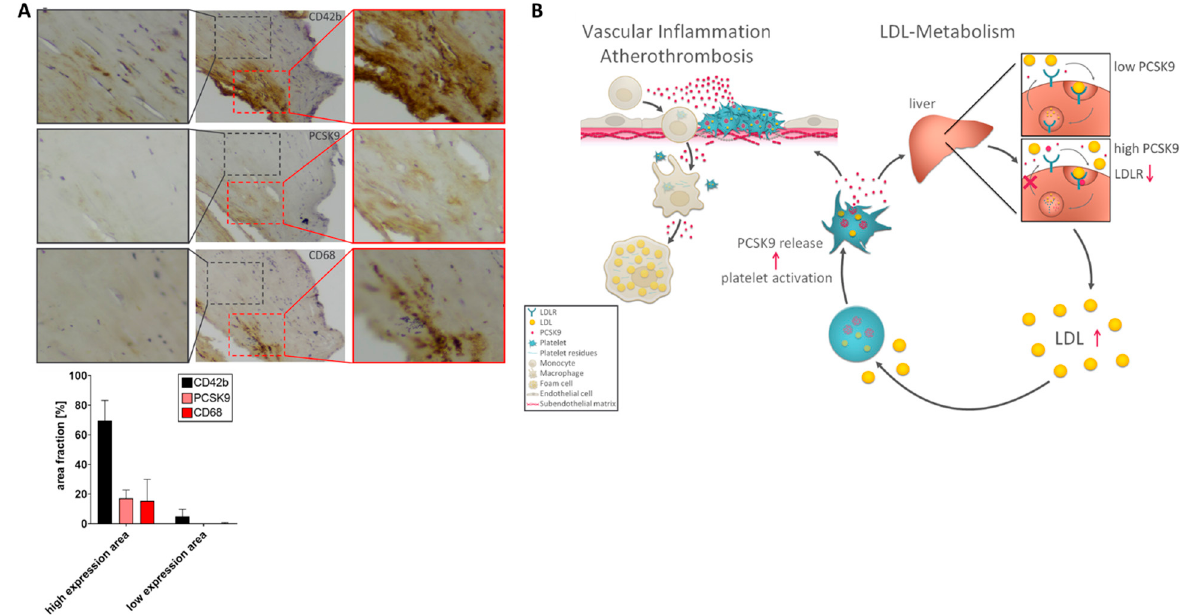
Figure 4. ( A ) CD42b, PCSK9, and CD68 immunostaining of human atherosclerotic carotid tissue. The representative immunostaining photomicrographs of CD42b, PCSK9, and CD68 expression in atherosclerotic tissue derived from endarterectomy specimen from carotid arteries are shown ( n = 3). ( B ) Proposed role of platelet-derived PCSK9 in LDL metabolism and atherothrombosis. Enhanced release of PCSK9 from platelets promotes LDLR degradation and the increase of plasma LDL. Platelet-PCSK9 induces monocyte migration, macrophage development, and enhanced thrombosis.